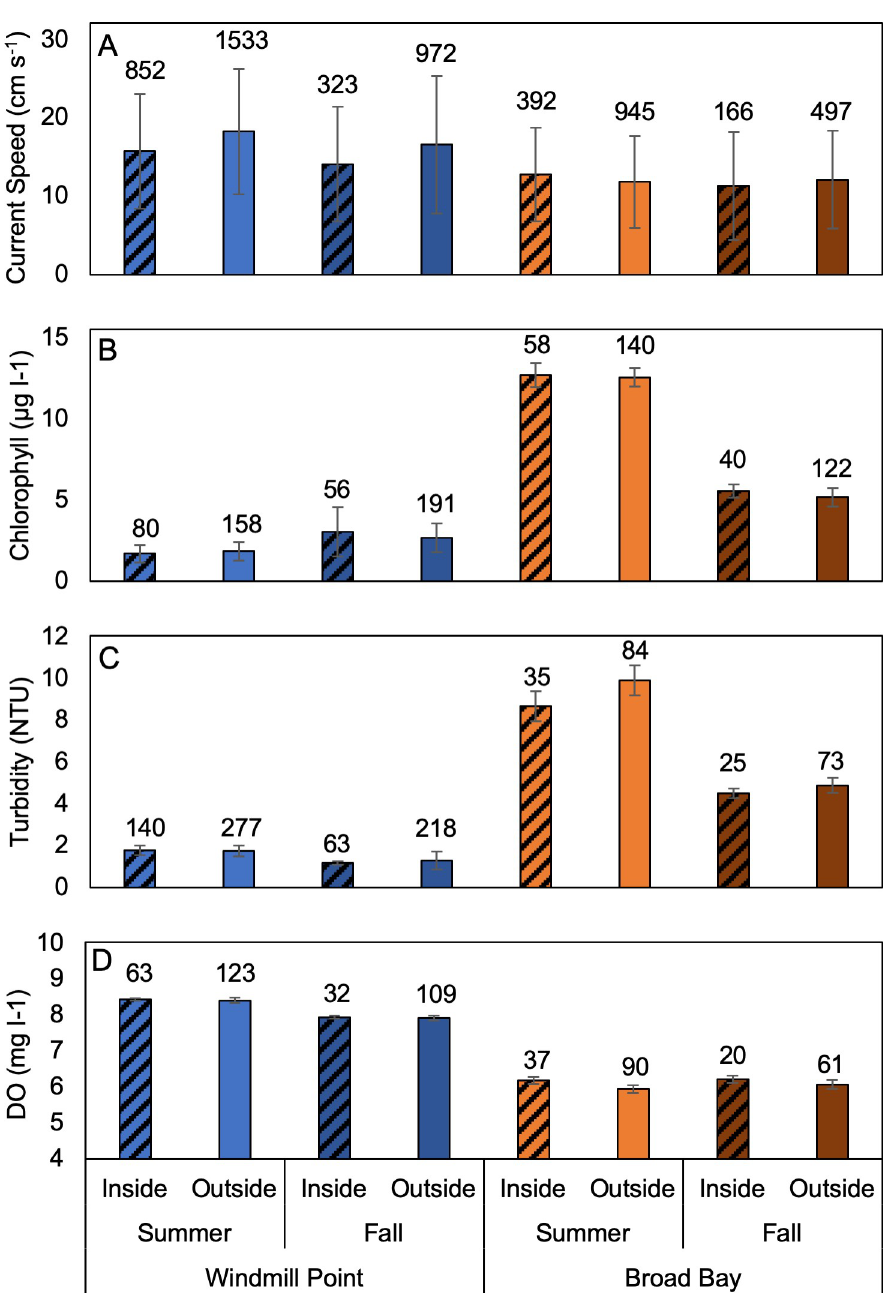
Fig 6. Seasonal comparison of current speed and water quality at two sites. (A) Current speed, (B) chlorophyll, (C) turbidity, and (D) DO. Error bars indicate ± one standard deviation. Sample sizes are shown above each bar. season (p = 0.014) but no interaction between farm effects and other factors. At Windmill Point, current speeds were significantly lower in fall than in summer (p < 0.001). At Broad Bay, current speeds were similar between seasons (p = 0.10). As seen previously for summer, there were significant differences between sites in the fall (p < 0.001). In contrast to previous analyses, a significant effect of the farm on current speeds was only found at Windmill Point